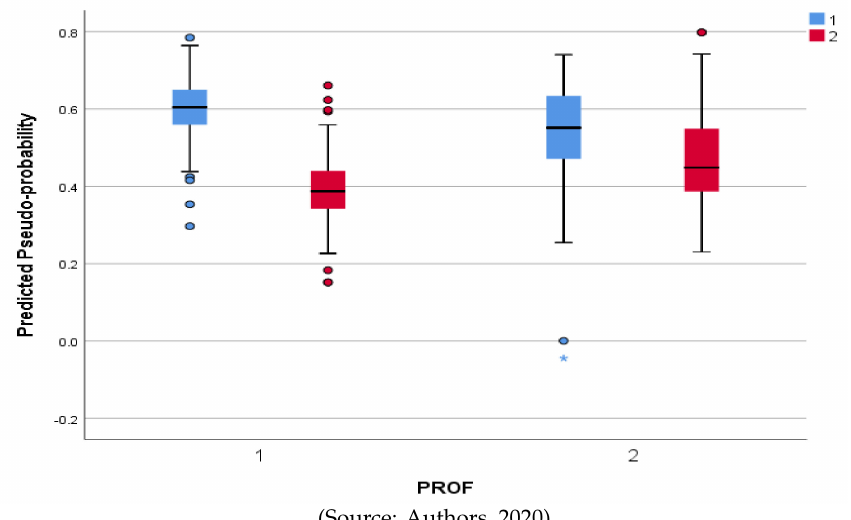
Figure 3. Predictive pseudo-probability of the second